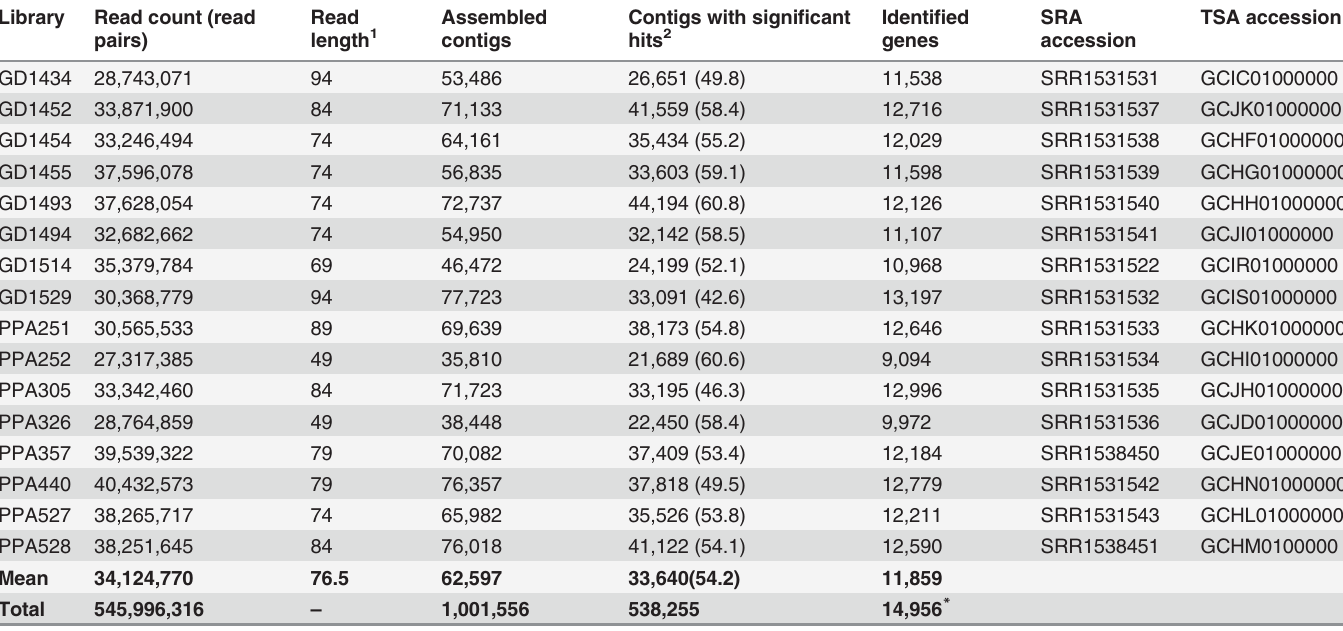
Table 1. RNA-seqdata and results of de novo assembly and gene annotation of 16 renal transcriptomes of Abrothrix hirta .